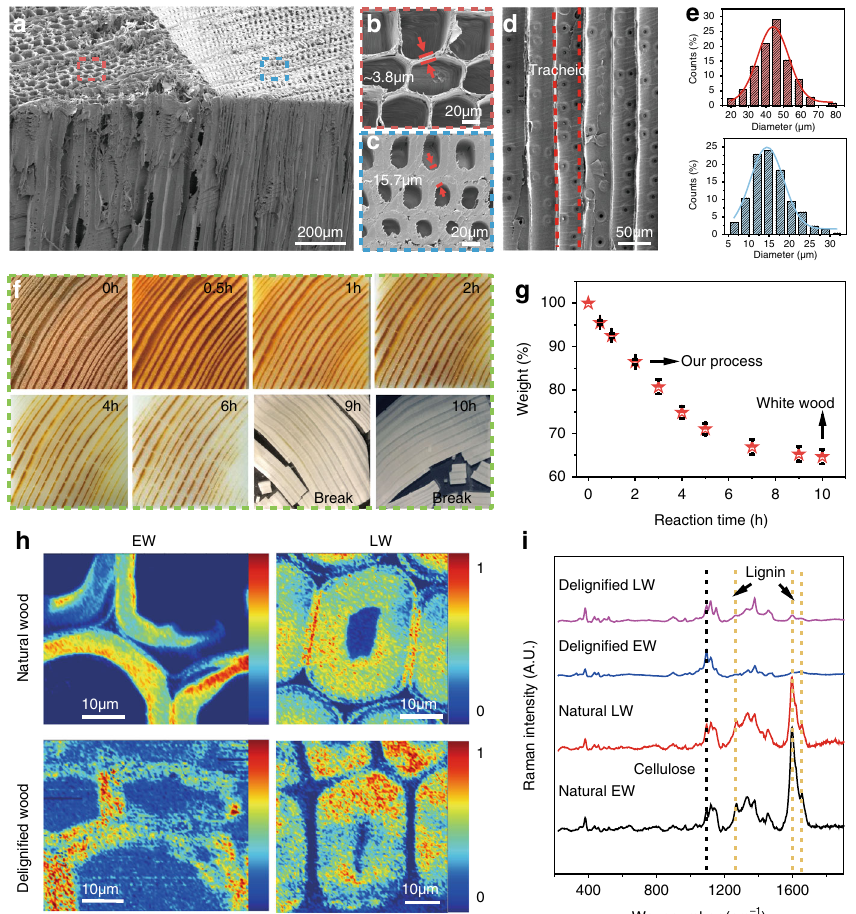
Fig. 2 Morphological and chemical characterizations of aesthetic wood. a The SEM image of Douglas fi r to show its mesoporous structure. b , c Magni fi ed SEM images of EW and LW to present the differences in microstructural lumina. d The aligned micro-sized channels with tracheids. e The pore diameter distributions of EW and LW in the natural Douglas fi r. f Photo comparison of color and pattern changes in wood templates during lignin removal process in the laboratory (0 – 10 h). g The weight loss behavior as a function of deligni fi cation process time. Error bars represent standard deviation. h Cell wall components of the EW and LW in natural wood (non-treated reference) and deligni fi ed wood cell wall (CW) after VCA. i The corresponding Raman spectra in ( h